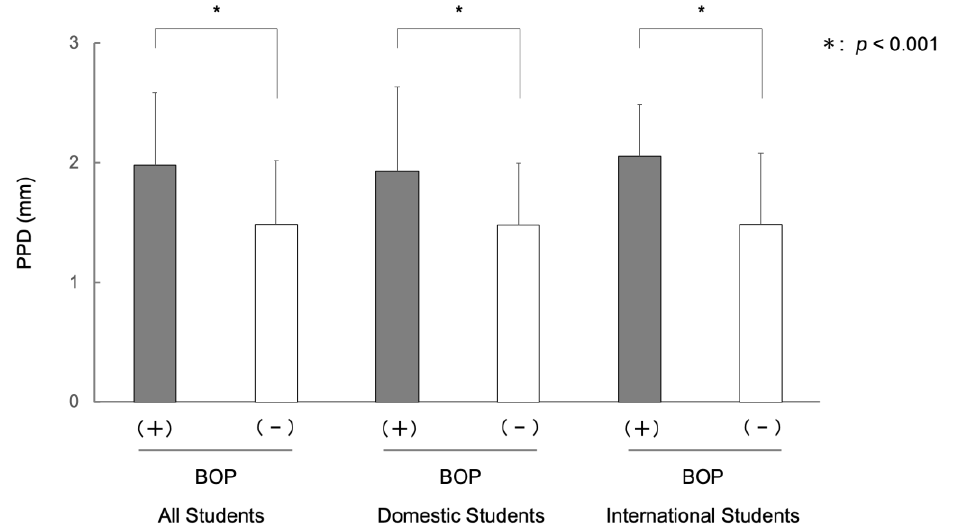
Figure 5. The association of bleeding on probing (BOP) with probing pocket depth (PPD) in inter- national and domestic university students in Japan. Note: The mean PPD for students with BOP was significantly greater than that for students without BOP ( p < 0.001). For both international and domestic students, the mean PPD for students with BOP was greater than that for students without BOP ( p < 0.001); there was no significant difference in PPD between international and domestic students for both students with BOP and students without BOP. Error bars denote the standard devi- ations of the data.